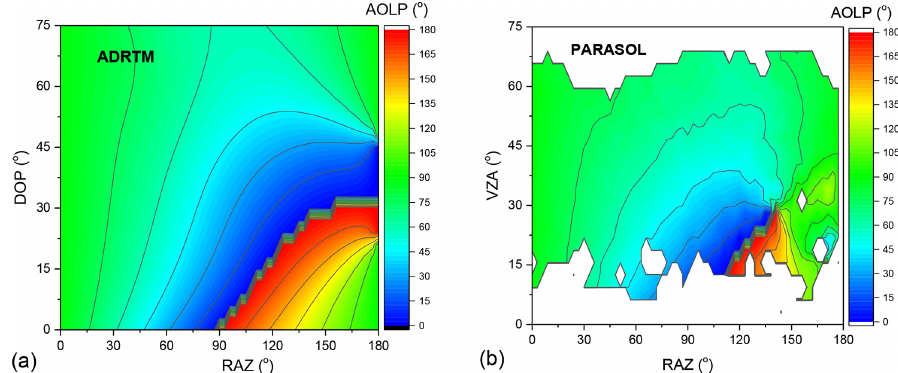
Figure 2. Same as in Fig. 1 but for the AOLP of the reflected light from the ADRTM ( a , AOD = 0 . 3) and the PARASOL ( b , AOD = 0 .